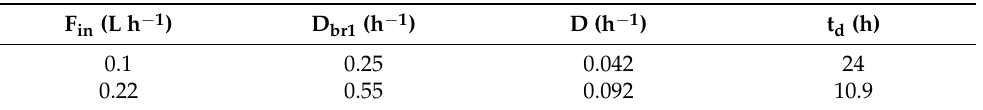
Table 1. Feeding rate F in , dilution rate D br1 for one bioreactor tank, dilution rate D for the cascade, residence time t d in the reactor